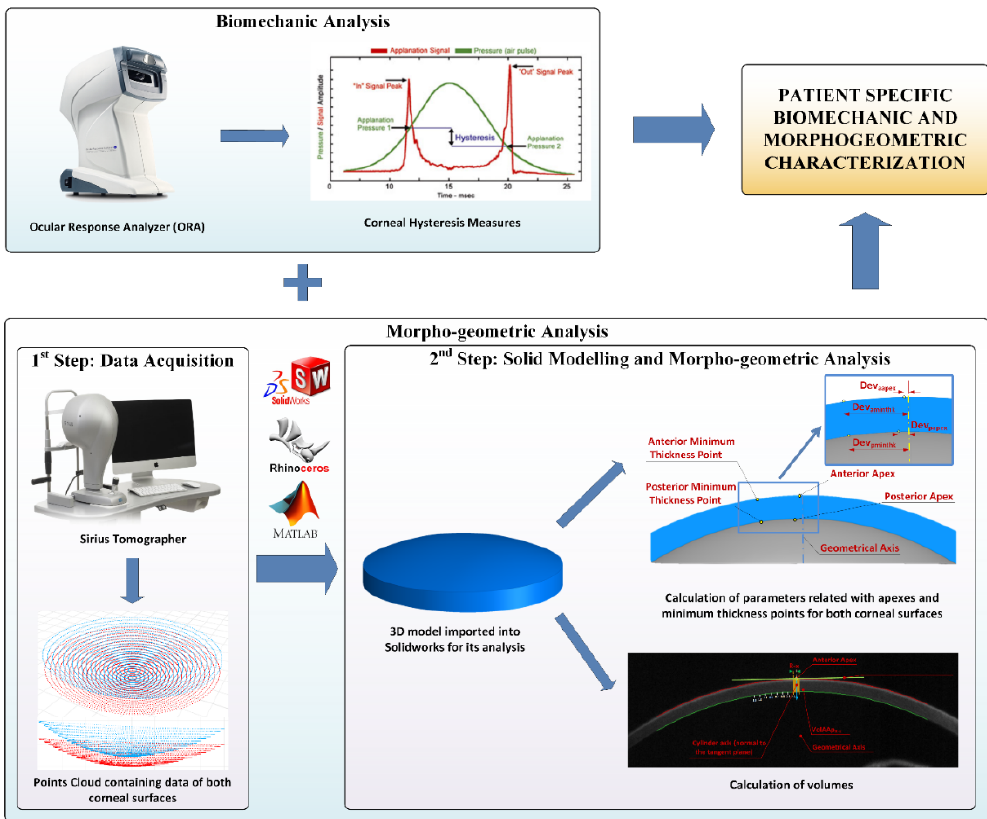
Figure 1. Procedure followed for patient specific biomechanical and morphogeometric characterization. Data obtained from the Ocular Response Analyzer (ORA) and Sirius tomographer allowed us to create a customized 3D model by means of a two-stepped procedure, in which several morphogeometric parameters related with areas and volumes can be studied, along with the corneal hysteresis measures.